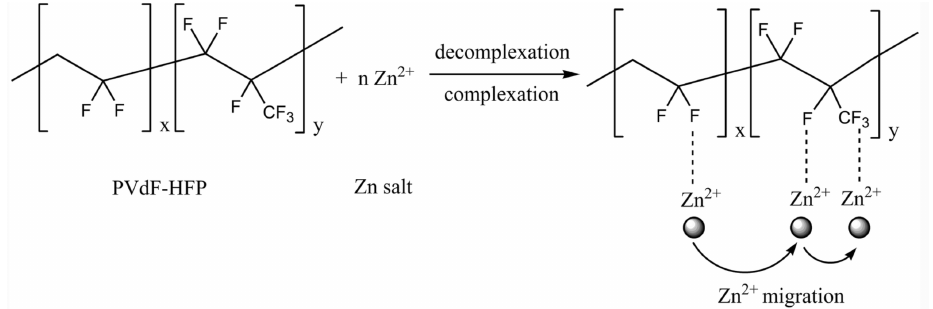
Figure 7. Reproduced with permission from reference [197]. Copywrite 2020. Springer Nature. Proposed transport mechanism through the polymer matrix in which Zn 2 + is complexed then decomplexed driving migration of the